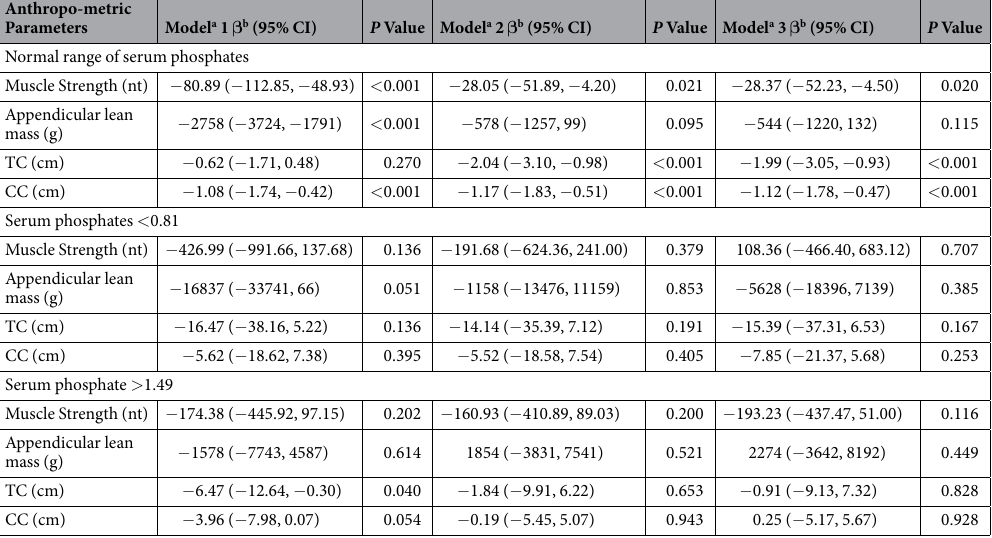
Table 1. Association between the serum phosphate and the anthropometric parameters. a Adjusted covariates: Model 1 = Unadjusted. Model 2 = Model 1 + age, sex, race/ethnicity, BMI, systolic blood pressure, serum fasting glucose, serum cholesterol, serum albumin, ALT, serum uric acid, C-reactive protein. Model 3 = Model 2 + history of congestive heart failure, coronary heart disease, angina/angina pectoris, heart attack, stroke, cancer/malignancy, smoking, moderate to vigorous recreational activity. b β coefficients was interpreted as change of telomere length for each increase in different anthropometric parameters. Abbreviation: TC, thigh circumference; CC, calf